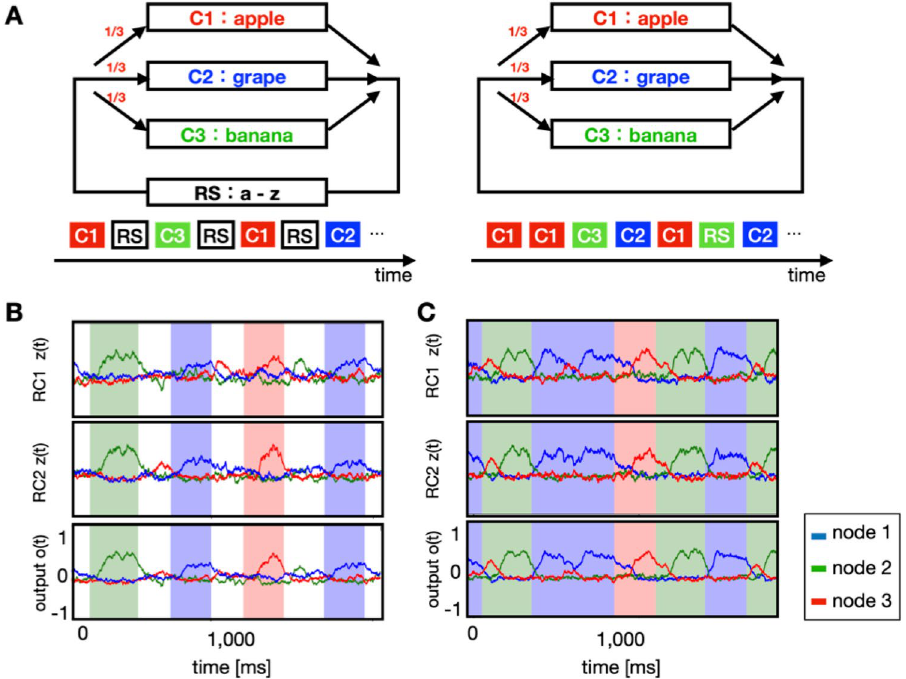
Figure 2. Learning of multimodal multiple chunks. ( A ) Left: Three chunks of apple (red), grape (blue), and banana (green) separated by random sequences recur at equal frequencies in the input. Right: These chunks are repeated without random sequence intervals. ( B ) The activity of the output units upon presenting each chunk while using input signals separated by random sequence intervals. The red, green, and blue shades indicate periods of learned input “apple,” input “banana,” and input “grape,” respectively. ( C ) The behavior of the output units upon presenting each chunk with input signals not separated by intervals. The red, green, and blue shades indicate periods of learned input “apple,” input “banana,” and input “grape,”